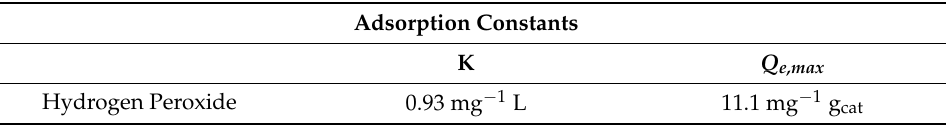
Table 3. Adsorption constants for hydrogen peroxide and ethanol.